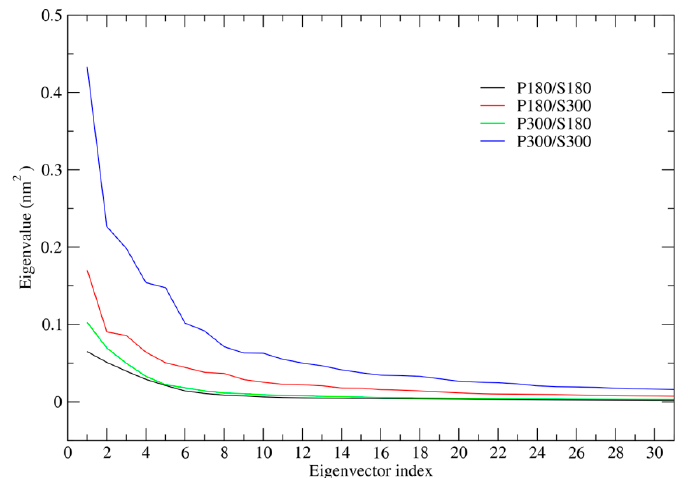
Figure 2. Eigenvalues as a function of eigenvector index derived from ED analyses of the joined trajectories at the four combined temperatures. Only eigenvalues of the first 30 eigenvectors (total is 837) are shown. Black line: P180/S180; red line: P180/S300; green line: P300/S180; blue line: P300/S300.